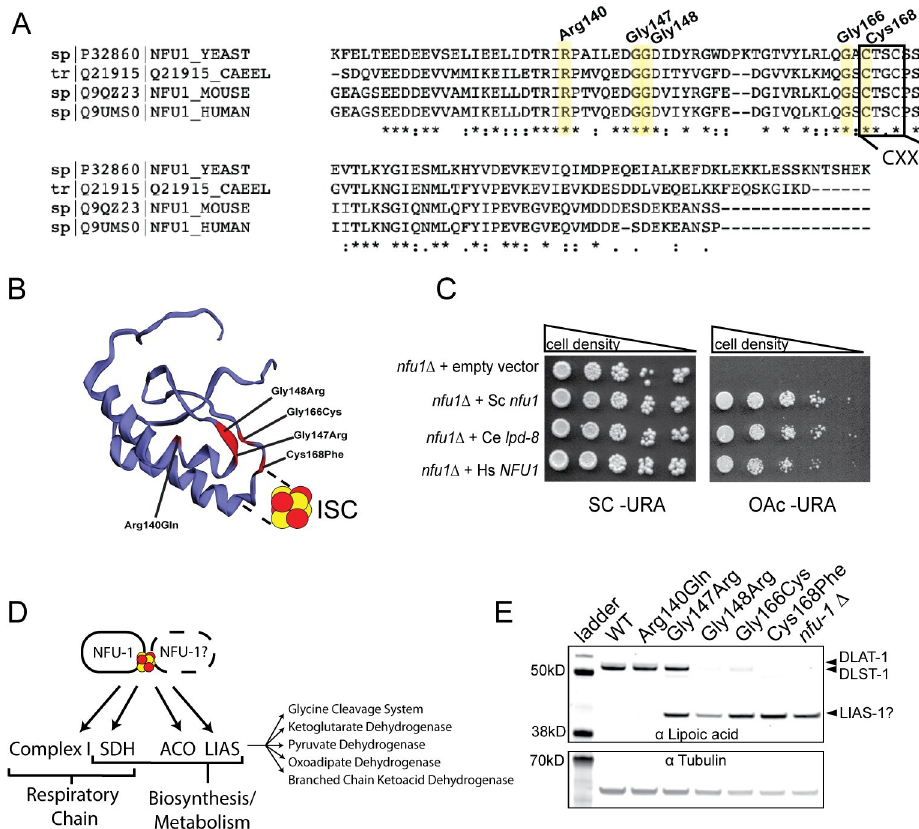
Fig 1. C . elegans nfu-1/lpd-8 is orthologous to human and yeast NFU1 . (A) Partial Clustal Omega alignment of yeast Nfu1, C . elegans NFU-1/LPD-8, mouse Nfu1, and human NFU1 highlighting five residues mutated in MMDS1 and the conserved CXXC ISC-interaction motif. (B) Predicted structure of the C . elegans NFU-1 C-terminal domain with mutated residues annotated in red and labeled with corresponding mutations. (C) Representative complementation assay with yeast nfu1 , C . elegans nfu-1/lpd-8 , and human NFU1 on complete (SC) and acetate (OAc) medium. Cell density indicated above images. (D) Known targets of NFU1/NFU-1 and downstream pathways/complexes affected. NFU1/NFU-1 predominantly functions as a homodimer, but other binding partners are possible (indicated by dotted line and question mark) (E) Representative western blot analysis of lipoylated proteins from L4 WT and nfu-1 mutants. Lipoylated proteins are above and tubulin (loading control) is below. DLAT-1 (E2 subunit of PDH; 53kD) and DLST-1 (E2 subunit of KGDH; 49.8kD) indicated to the right. The lower band is consistent with LIAS-1 (39.8kD) but could not be verified.